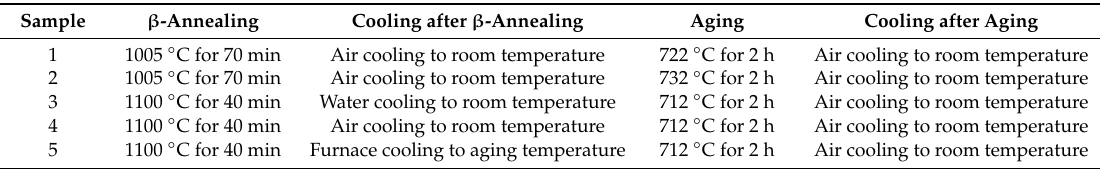
Table 2. Heat-treatment